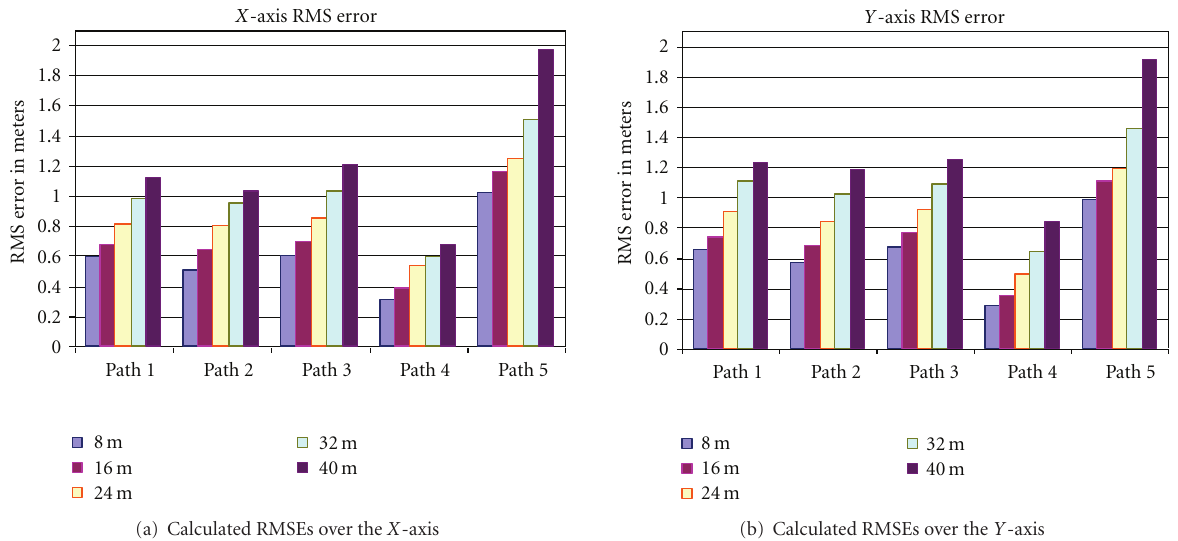
Figure 18: RMSE of the five paths tested in experiment II. The test was performed over five di ff erent distances of TG points.